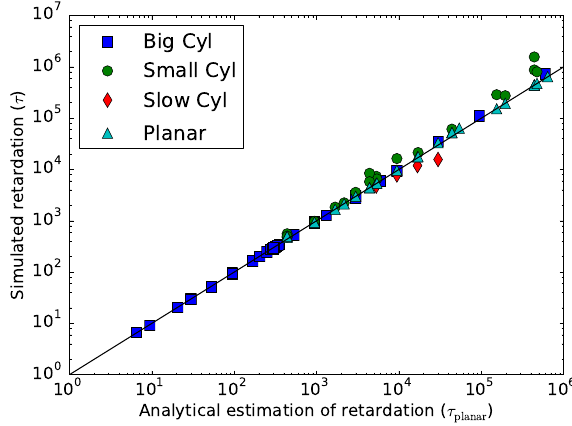
Figure 2. A comparison of the transmission factors of peaks in the simulations of Gaussian temperature pulses against the modi- fied form of the analytical solution for a sinusoidal input tempera- ture (Eq. 36). Cylindrical cases are corrected by an additional fac- tor (Eq. 37) that is a function of the dimensionless parameter (cid:50) . These modified forms of the analytical solution provide a close fit to the simulation results for most cases. Big Cyl and Small Cyl indicate a conduit in cylindrical coordinates with a D H ≥ 1m and a D H < 1m, respectively. Slow Cyl indicates a conduit in cylindri- cal coordinates with a V ≤ 0 . 0352ms − 1 . Planar indicates a conduit in planar coordinates. The graph includes a 1 : 1 line.